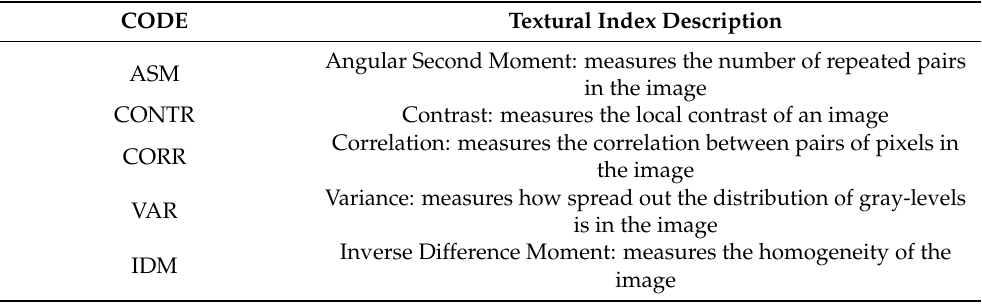
Table 4. Textural indices calculated using the Gray-Level Co-occurrence Matrix